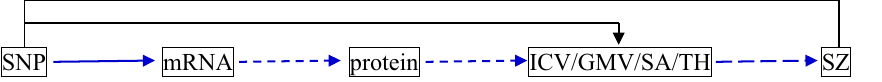
Figure 1. Regulatory pathway from SNP to schizophrenia. [Solid lines, pair-wise associations examined in the present study; dash lines, potential pair-wise associations predicted by literatures; arrows, regulatory effect directions; ICV, intracranial volume; GMV, subcortical gray matter volume; SA, cortical surface area; TH, cortical thickness; SZ,